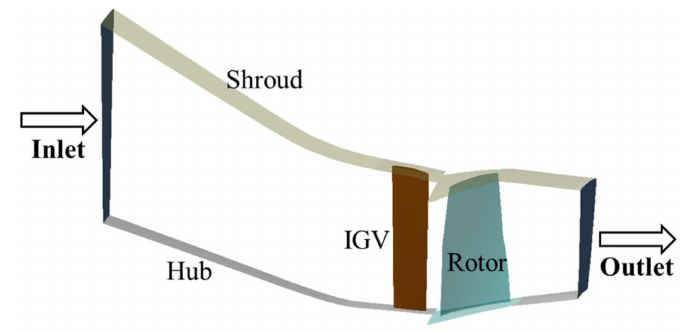
Figure 6. Computational